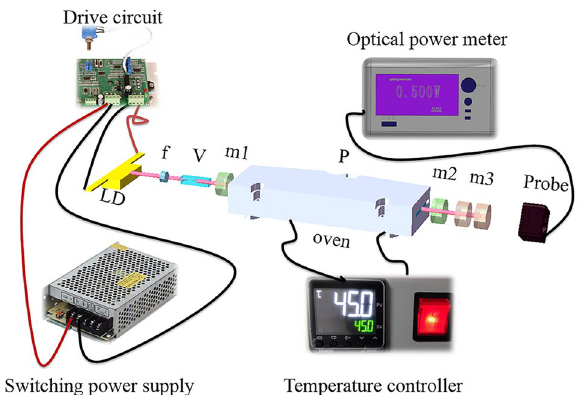
Figure 1. Experimental schematic diagram of IC-OPO. LD: solid 808 nm laser diode; f: focusing lens; V: Nd:YVO 4 crystal; m1: IC-OPO input mirror; P: PPLN crystal; m2: IC-OPO output mirror; m3: dichroic mirrors (Solid Works 2018, https ://www.solid works .com/, Microsoft Office Power Point 2007, https ://www.offic e.com/, Adobe Photoshop CC 2018, https ://www.adobe .com/cn/produ cts/photo